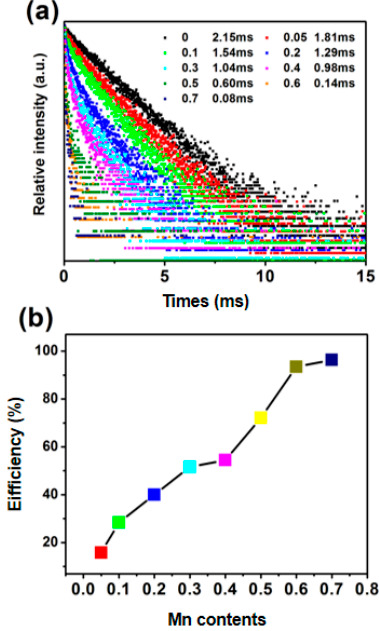
Figure 6. ( a ) Fluorescence lifetime of the Tb 3+ ion with different Mn 2+ contents in the CTP: x Mn 2+ ( x = 0.05, 0.1, 0.2, 0.3, 0.4, 0.5, 0.6 and 0.7) ( λ ex = 377 nm, λ em = 542 nm); and ( b ) the energy transfer efficiency of CTP: x Mn 2+ ( x = 0.05, 0.1, 0.2, 0.3, 0.4, 0.5, 0.6 and 0.7).